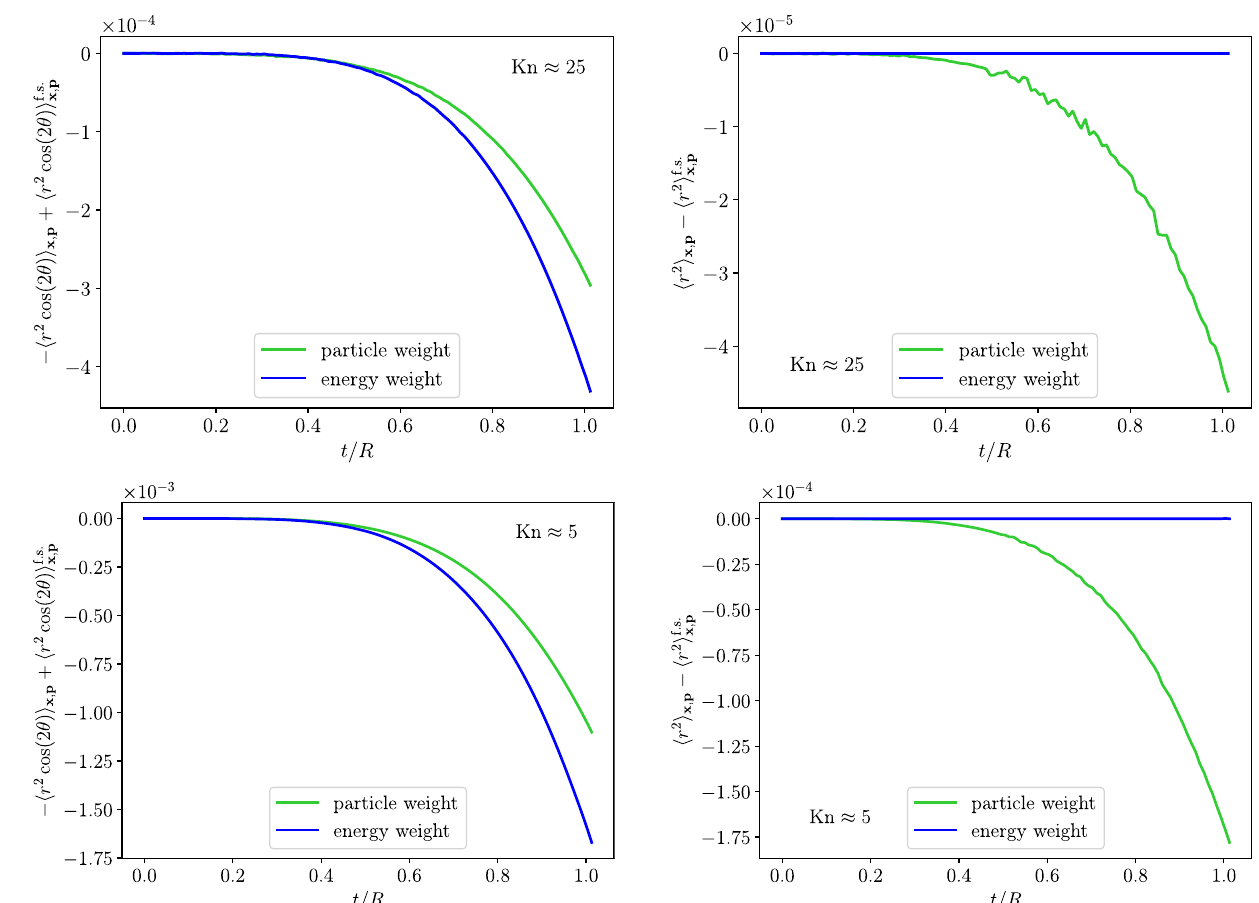
a collisionless